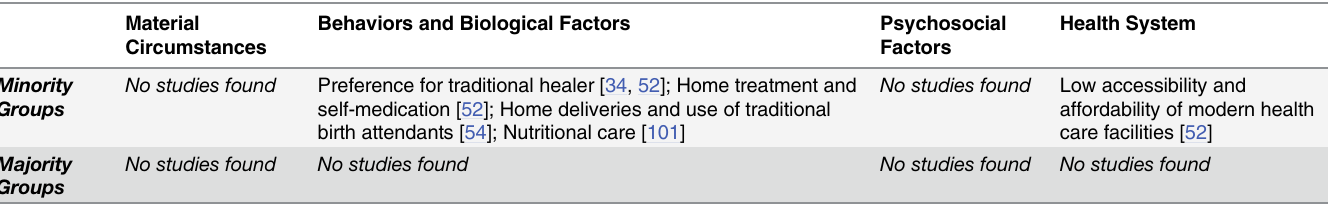
Table 5. Ethnicity and Child Health in